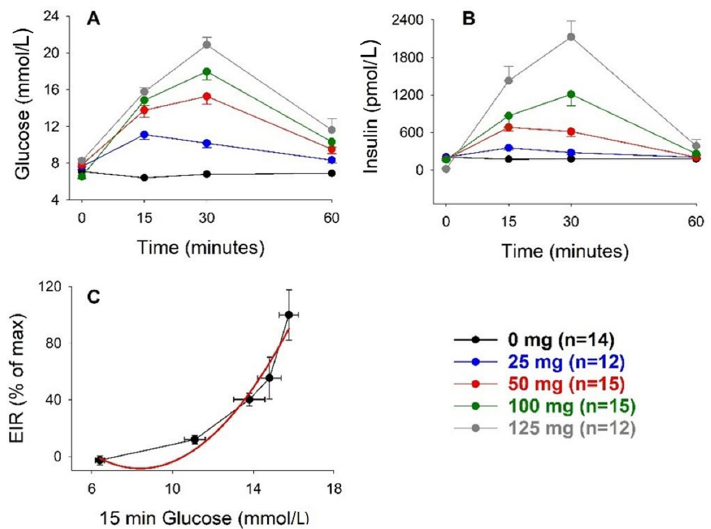
Figure 3. Glucose ( A ) and insulin ( B ) levels before and after oral administration of glucose (0–125 mg per mouse) and the relation between the early insulin response (EIR) and 15 min glucose level in C57BL/6J mice ( C ). Original data reported in [18]. Means ± SEM are shown. n indicates the number of animals in each group. Red line indicates the best curve fit for the relations.